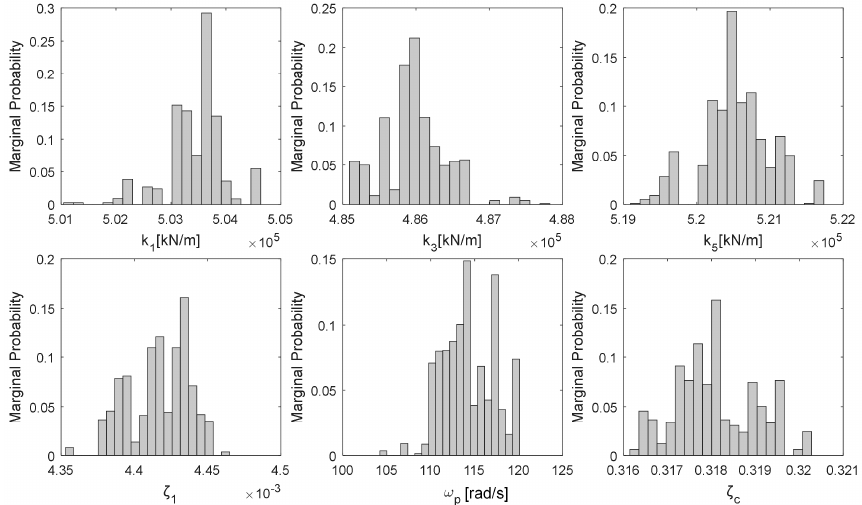
Figure 17. Generated samples for the six estimation parameters ( k 1 , k 3 , k 5 , ζ 1 , ω p , ζ c ).